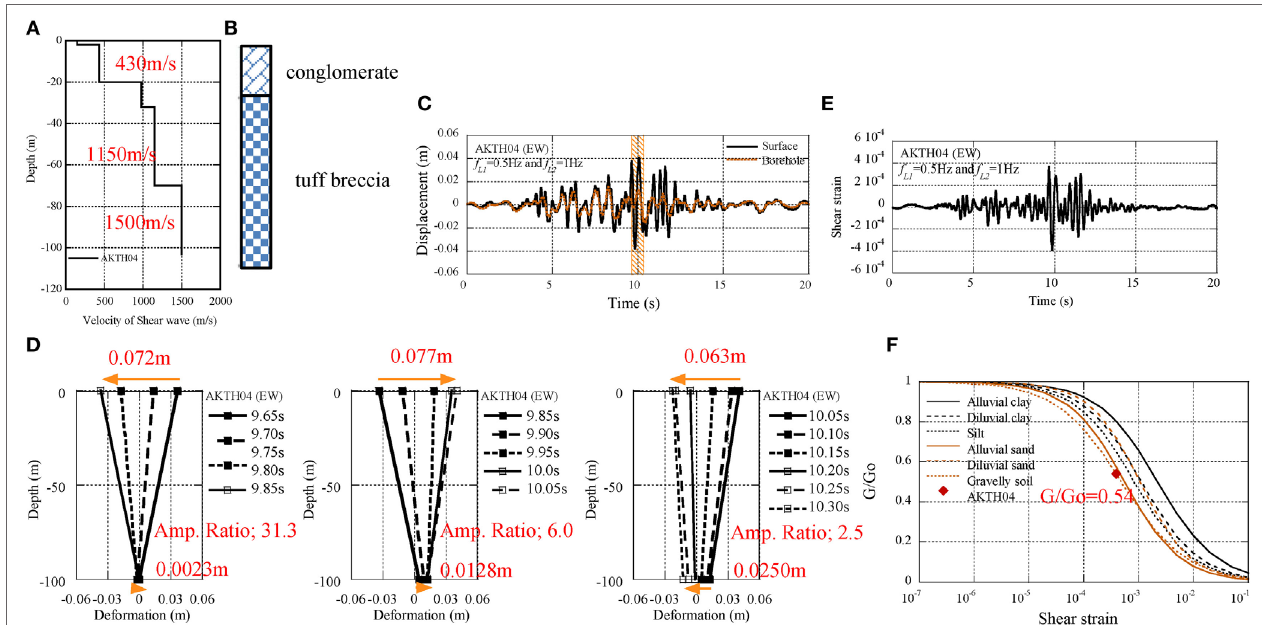
FigUre 12 | Deterioration of underground soil at AKTH04, (a) profile of V S , (b) soil property, (c) displacement profile at surface and borehole, (D) deformation process of surface soil from 9.65 to 10.3 s, (e) shear strain profile, (F) deterioration ratio of surface